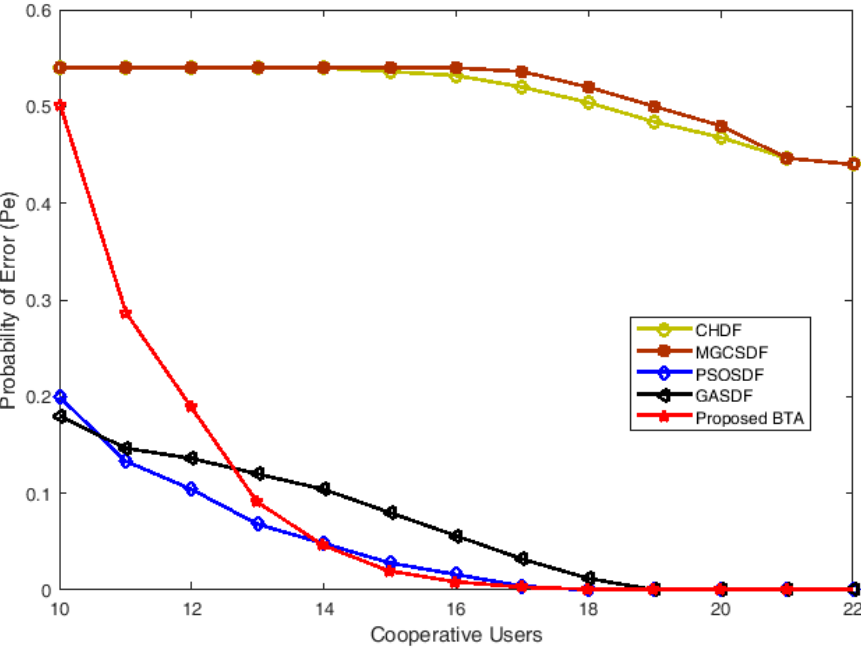
Figure 11. Probability of error vs. cooperative users with the AY category of MUs.